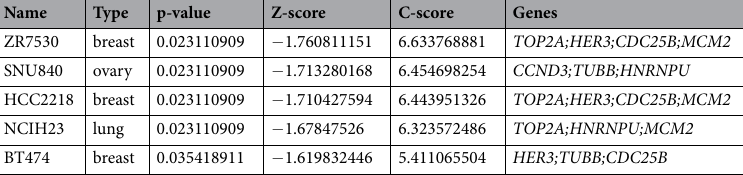
Table 3. Top 5 enriched cell lines from cancer proliferation marker enrichment analysis. Cell line name, type, p-value, Z-score, C-score and genes enriched in each cell line are